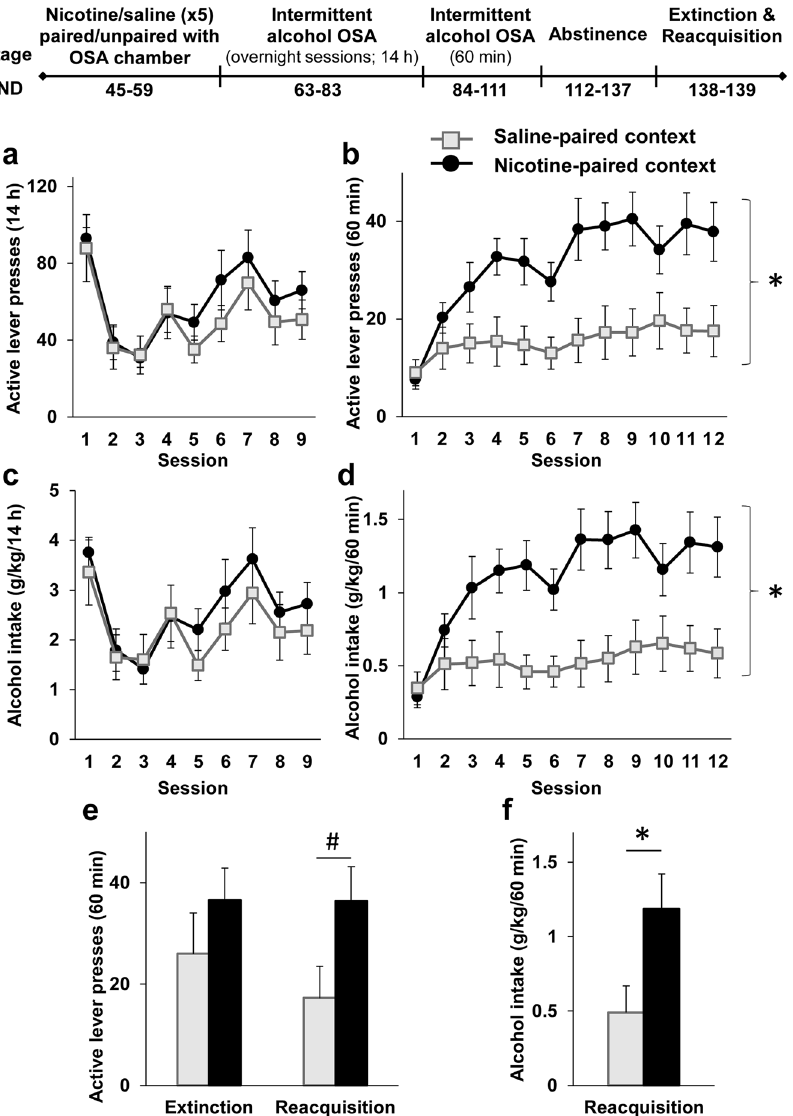
Figure 4. Adolescent nicotine pre-treatment paired with the operant chambers but not with a different context induces long-lasting enhancement of operant alcohol self-administration and relapse in adulthood. Rats were treated with 5 nicotine and saline injections on PND 45–59. Nicotine treatment was either paired with the operant self-administration (OSA) chambers (Nicotine-paired context group), or unpaired with the OSA chamber by placing the rats in a neutral different context following nicotine treatment, while pairing the chamber with saline (Saline-paired context group). On PND 63 rats began intermittent operant alcohol self- administration training three days a week (fixed ratio 1; FR1) for 3 weeks. On PND 84, rats began intermittent operant training (FR1) of 60 min three days a week for 4 weeks. Rats were then subjected to 4 weeks of abstinence in the home cage, followed by an extinction and reacquisition sessions to test relapse to alcohol seeking and drinking, respectively. ( a–f ) Means ± SEM of the number of active lever presses ( a , b , e ) or alcohol intake normalized to body weight ( c , d , f ) during the overnight sessions ( a and c ), 60-min sessions ( b and d ) or extinction and reacquisition sessions ( e , f ). Mixed-model ANOVA; Overnight sessions: A main effect of Session for active lever presses [F(8,112) = 8.69, p < 0.0001] and for alcohol intake [F(8,112) = 6.71, p < 0.0001], but no significant main effect of Context-pairing and no significant Context-pairing X Session interaction (p > 0.1); 60- min sessions: A main effect of Context-pairing for active lever presses [F(1,14) = 8.12, p < 0.05] and for alcohol intake [F(1,14) = 8.6, p < 0.05], a main effect of Session for active lever presses [F(11,154) = 9.8, p < 0.0001] and for alcohol intake [F(11,154) = 8.62, p < 0.0001], and a significant Context-pairing X Session interaction for active lever presses [F(11,154) = 3.67, p < 0.001] and for alcohol intake [F(11,154) = 3.95, p < 0.0001], which was driven by simple effects of Session for Nicotine-paired context group (F(11,77) > 9.62, p’s < 0.0001) but not for the Saline-paired context group (p’s > 0.1). Extinction test: active lever presses, t(13) = 1.06, p > 0.1; Reacquisition test: active lever presses, t(13) = 2.06, p = 0.06, alcohol intake, t(13) = 2.31, p < 0.05. n = 7–8 per group; * p < 0.05; # p =